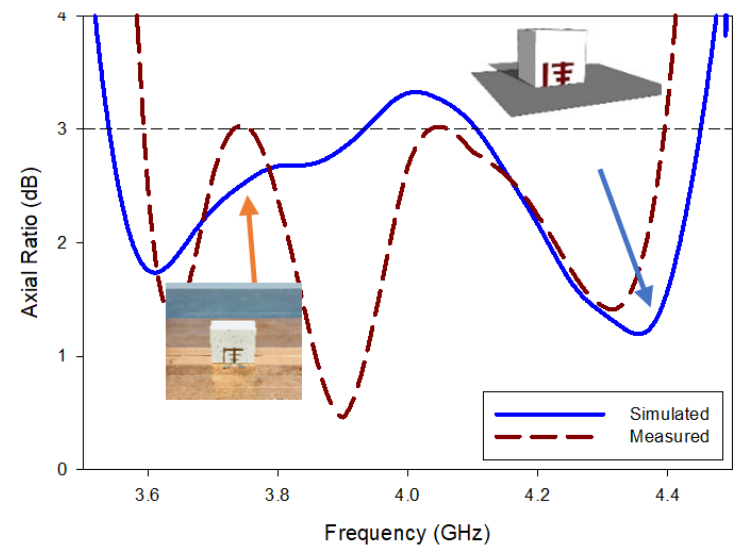
Figure 13. Assessment of the AR of fabricated and simulated RDRA.